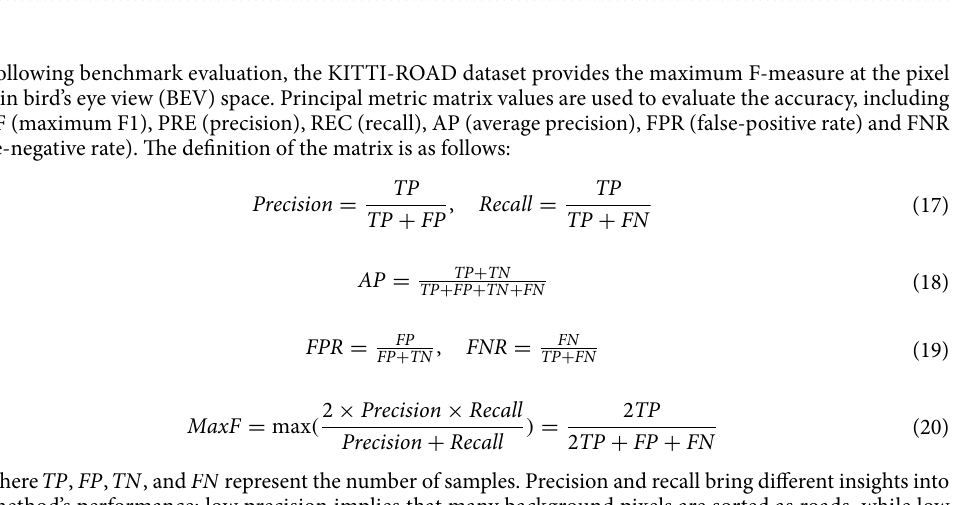
Table 1. Comparison results under different modalities on validation dataset